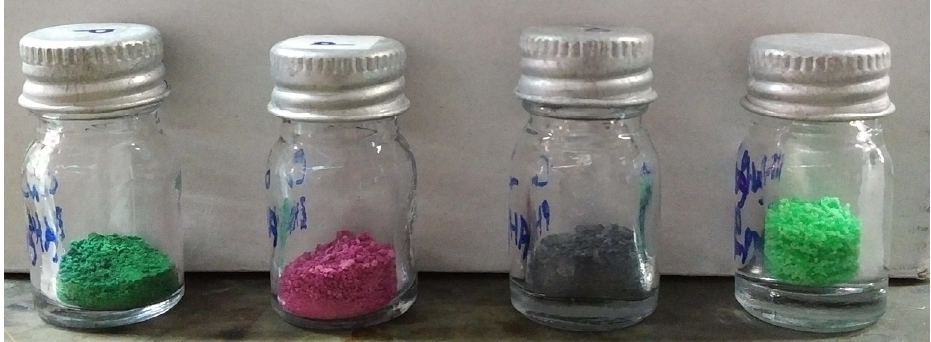
Figure 1. Poly(hydroxamic acid) with metal complex as the ligand-Cu (left), ligand-Co (second left), ligand-Cr (third from left), and ligand-Ni (utmost right).